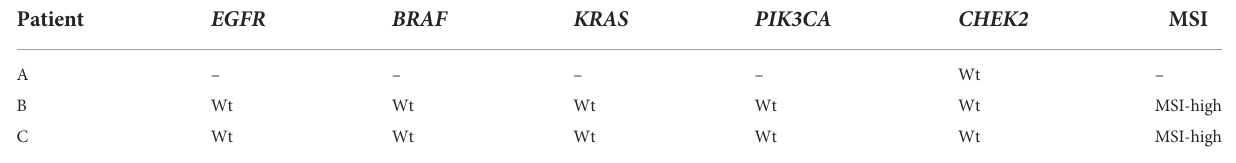
TABLE 1 Results of activation mutations and MSI